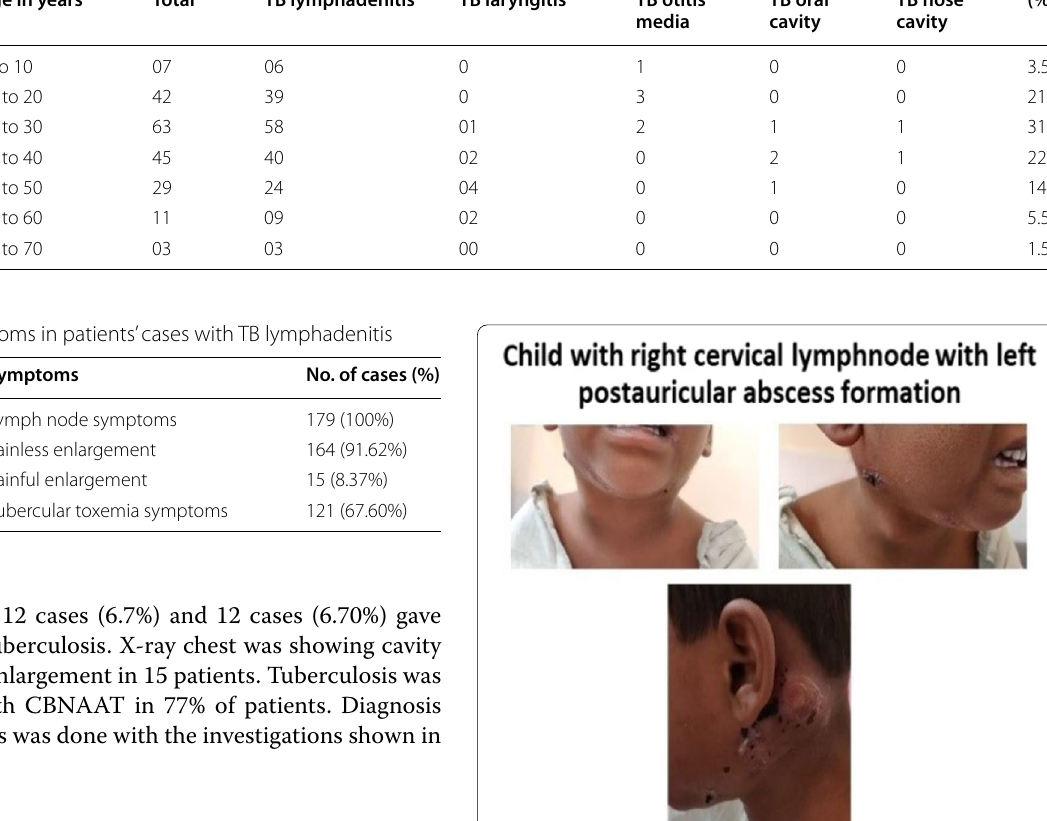
Table 1 Distribution of ENT and neck tuberculosis cases according to age Sr. no.